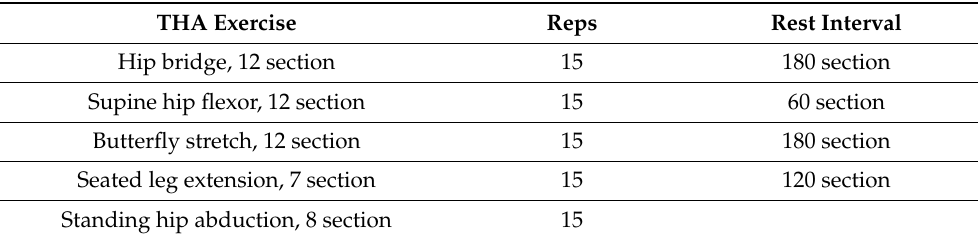
Table 2. Recommended remote exercises for the first 7 days of post-operative